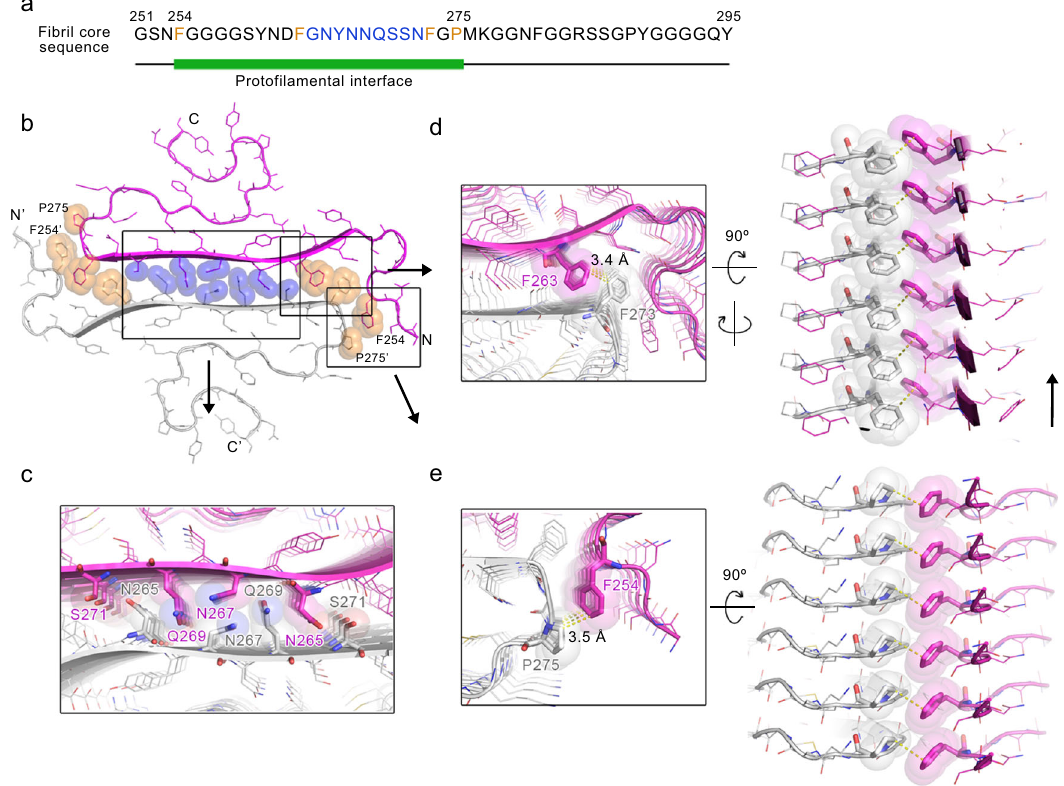
Fig. 3 The interface between hnRNPA1 LC proto fi laments. a The primary sequence of the hnRNPA1 fi bril core. The green bar marks the region of the interface between proto fi laments. Residues forming the steric zipper in the interface are highlighted in blue. Residues forming π -stacking and hydrophobic interactions fl anking the steric zipper are highlighted in orange. b Top view of the hnRNPA1 LC fi bril structure. Side chains that are involved in the interactions between proto fi laments are shown in spheres. Among them, the polar side chains in the steric zipper are colored in blue; the Phe and Pro side chains are colored in orange. The two proto fi laments are colored in magenta and gray, respectively. The framed regions are zoomed in and shown in top and side views in c – e